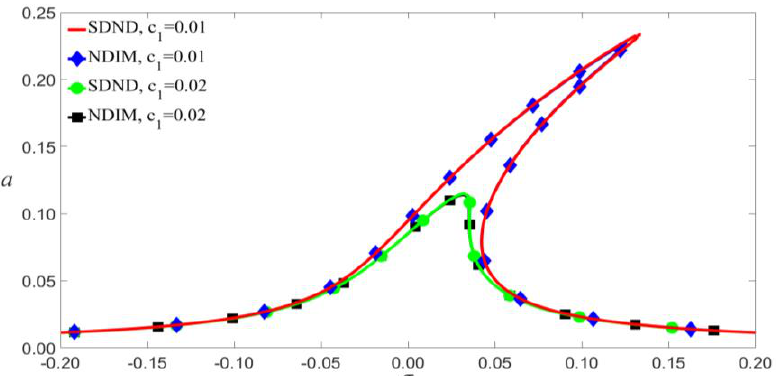
Figure 11. Frequency-response curves of primary resonance for V DC = 1.5 V, V AC = 0.08 V, and P 0 = 0.205 N.